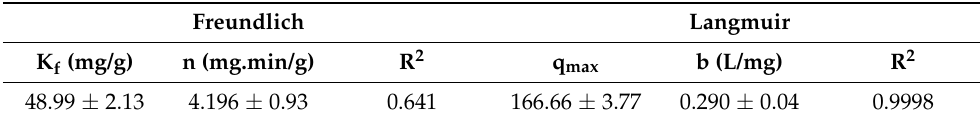
Table 3. U(VI) adsorption isotherm parameters of SiO 2 /CS.